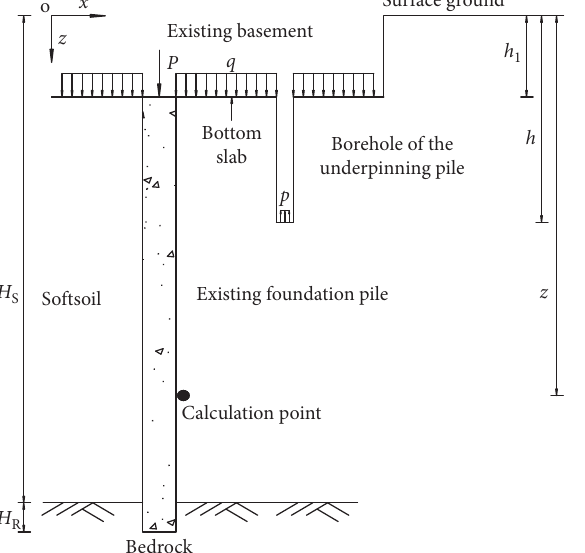
Figure 2: Calculation model of underpinning pile drilling construction.